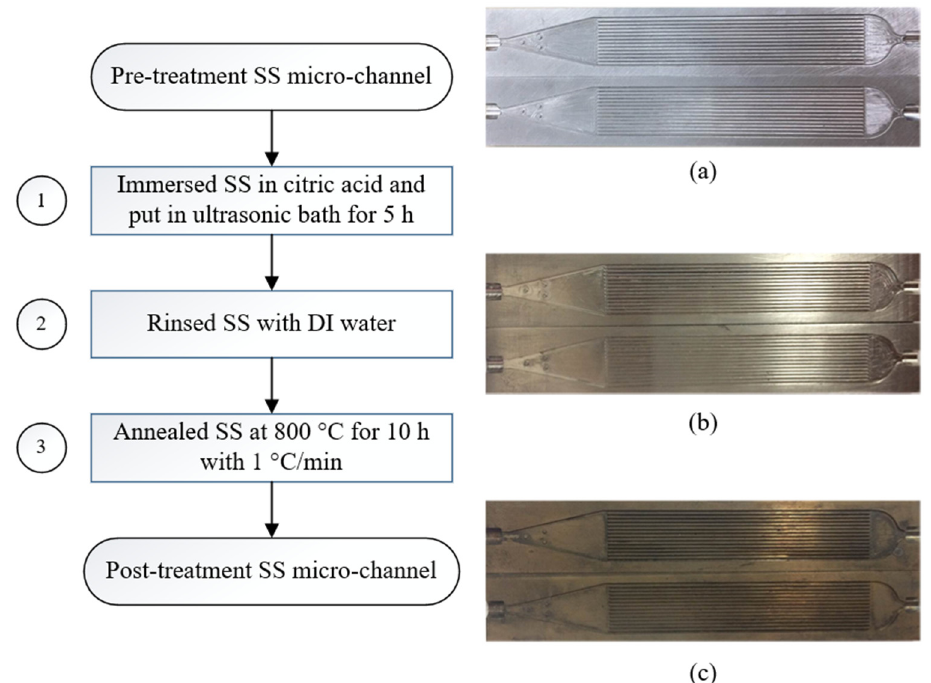
Figure 9. Steps of micro-channel pre- and post-treatment preparation: ( a ) before cleansing, ( b ) after cleansing with citric acid, and ( c ) after annealing at 800 °C.